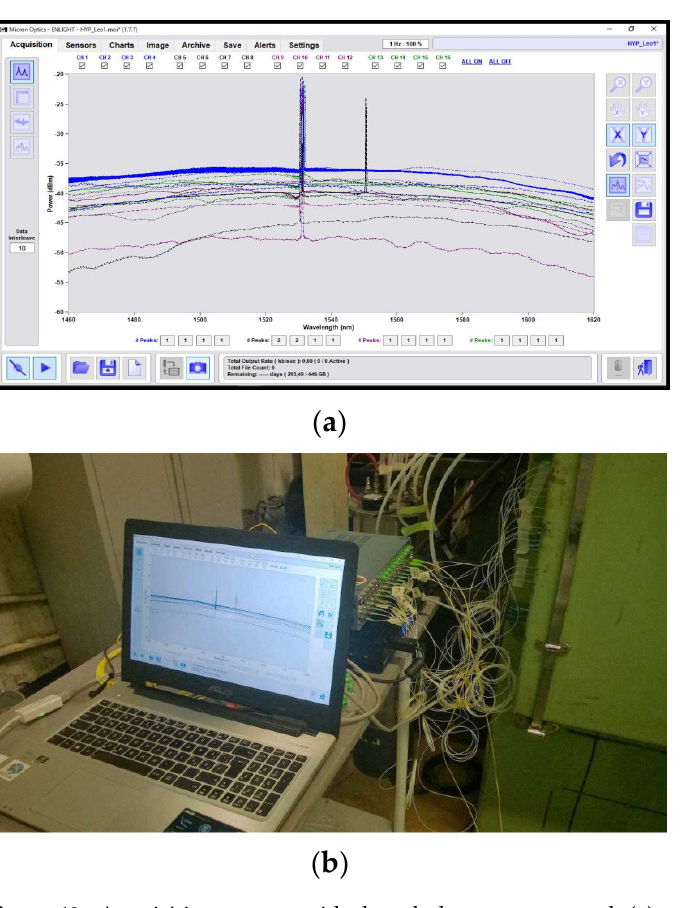
Figure 12. Acquisition system with the whole sensor network ( a ); magnified part of the Micron Optics Enlight software containing the whole sensor network spectrum ( b ).